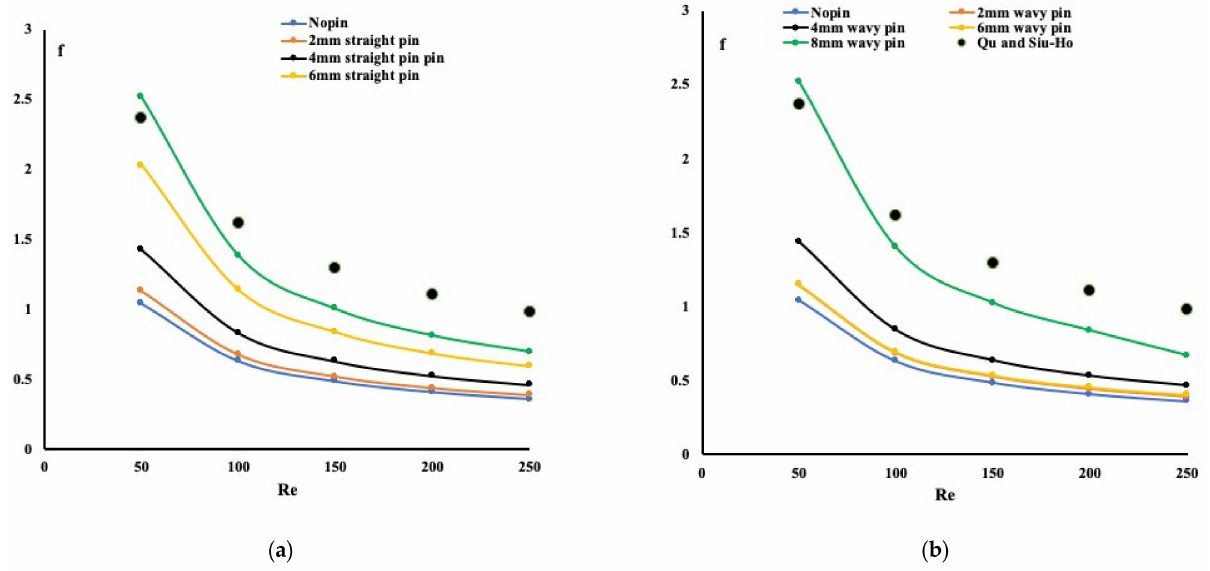
Figure 8. Variation in friction coefficient with Reynolds number (( a ) Straight pin-fins mini-channels, ( b ) Wavy pin-fins